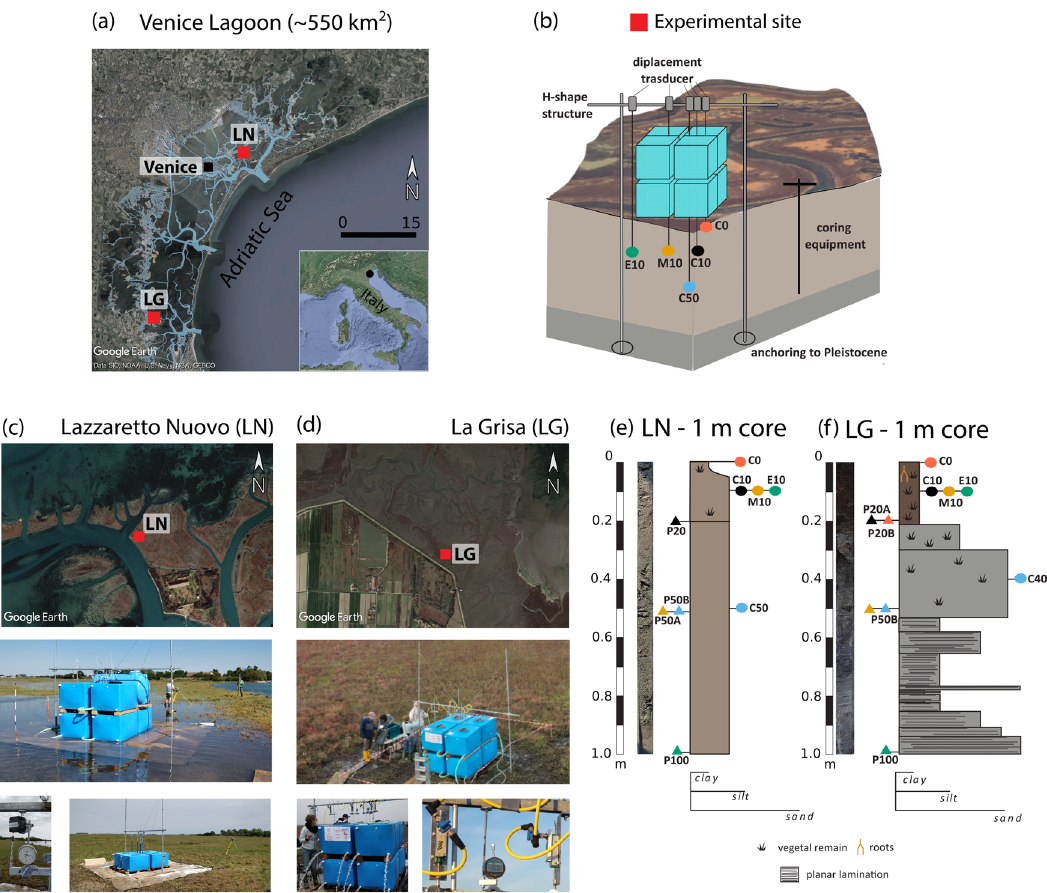
Fig. 2 The loading experiments in the Venice Lagoon (Italy). a Map of the Venice Lagoon with the locations of the LN and LG marshes where the loading experiment was carried out in July 2019 and October 2020, respectively. b Sketch of the experimental set-up showing the position of the monitoring instruments and the H-shaped structure used as stable reference for the displacement transducers and anchored on the Pleistocene sediments. c , d Satellite images of the LN and LG marshes and photos taken during the ongoing experiments. At LN ( c ) the photos show the experimental area loaded with 4 tanks and 8 tanks, in this latter case with the marsh platform submerged during high tide, and a detail of the instruments used to monitor vertical displacements. At LG ( d ) the photos show the experimental area with the 8 tanks (drone photo by Rodrigo Gomila), a detail of the tanks during an emptying (unloading) phase, and the displacement transducers. e , f Stratigraphic pro fi les of the upper 1 m subsoil at LN and LG, respectively. Manual augering equipment was used to characterize the subsurface stratigraphy and collect undisturbed soil samples and cores of the marsh at the two sites in the close vicinity of the loading experiments. The two stratigraphic columns are accomplished with the position of the sensors, which are represented using the same symbols adopted in Fig.